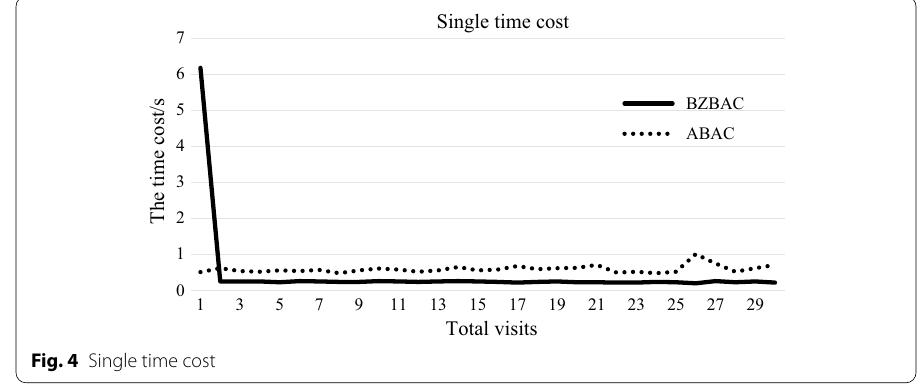
Fig. 4 Single time cost